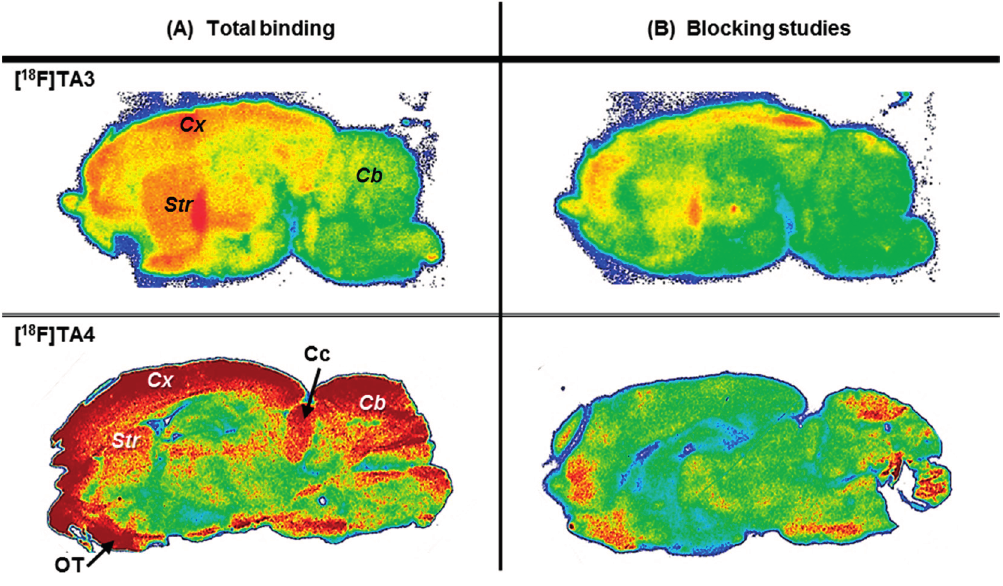
Figure 6. Representative autoradiographic images of sagittal rat brain slices: ( A ) In vitro distribution of activity after incubation with ~1 MBq/mL of [ 18 F] TA3 or [ 18 F] TA4